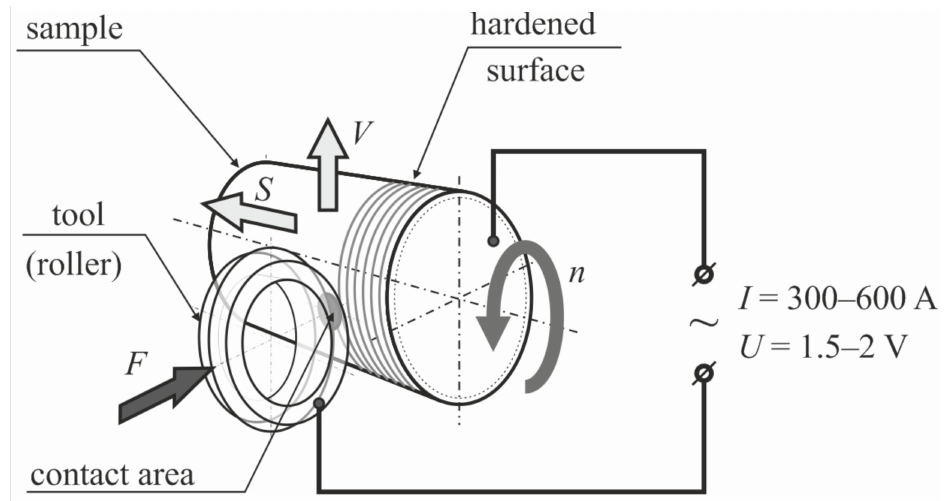
Figure 1. Schematic diagram of the electromechanical treatment processing; V : processing speed; S : feed rate; F : deforming force; I : current; U : voltage; n : rotation speed; the arrows indicate direction of rotation, velocity, feed and force